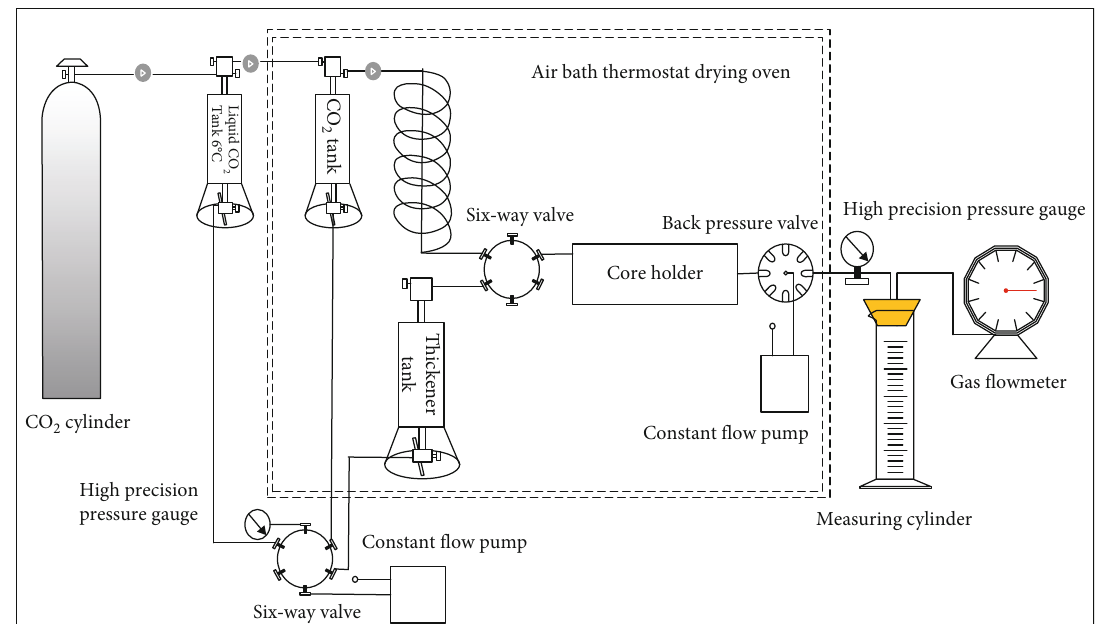
Figure 1: Flowchart of the damage test apparatus for CO